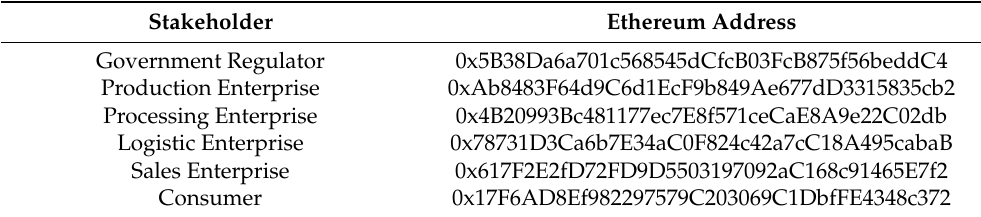
Table 5. The Ethereum address of each